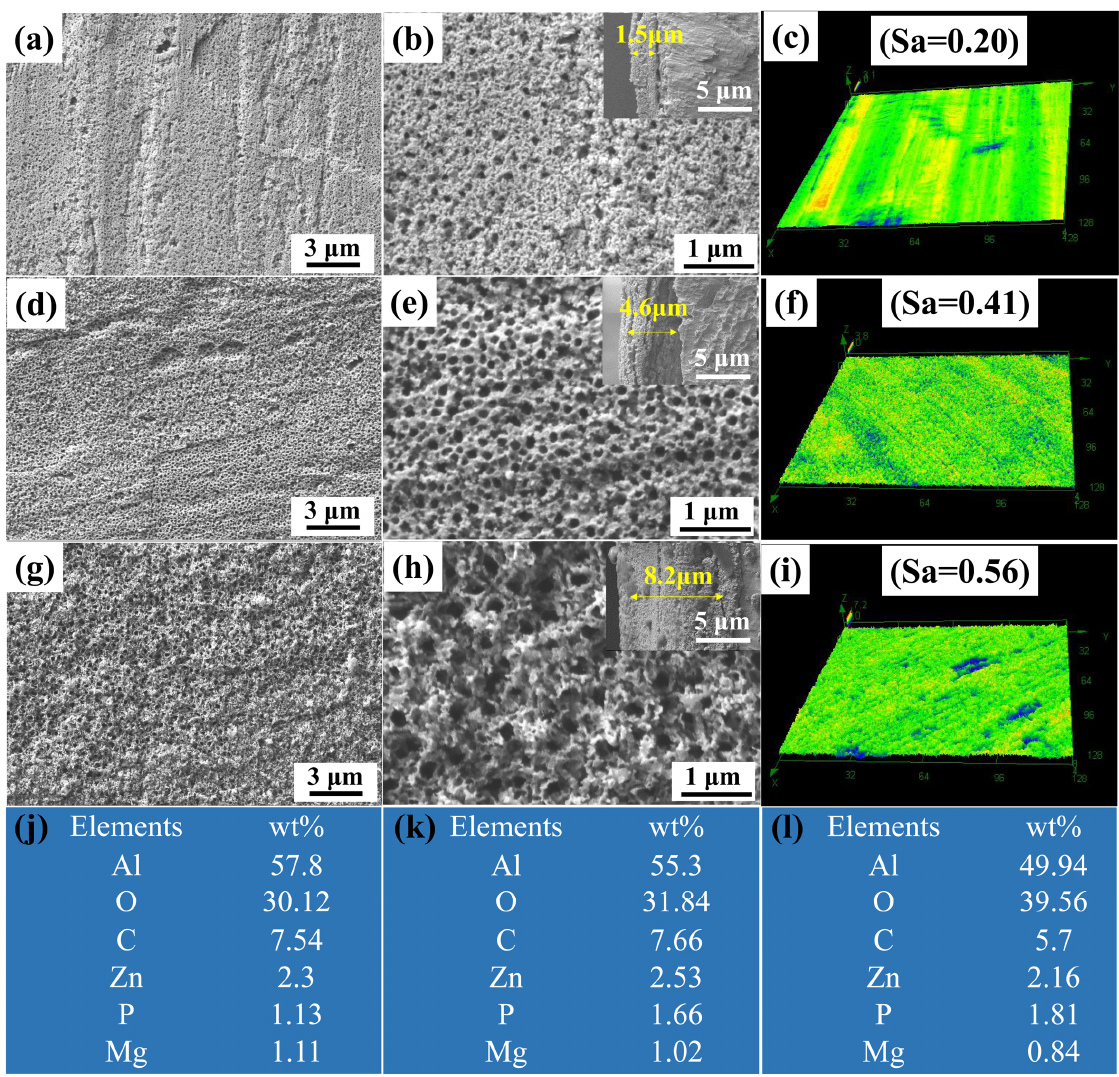
Figure 2. SEM images of anodic oxide film: ( a , b ) 5 min, ( d , e ) 10 min and ( g , h ) 20 min; the insets show cross-section SEM images of anodic oxide films. Laser scanning confocal microscopic images of anodic oxide films: ( c ) 5 min, ( f ) 10 min and ( i ) 20 min. EDS spectra of anodic oxide films: ( j ) 5 min, ( k ) 10 min and ( l ) 20 min.